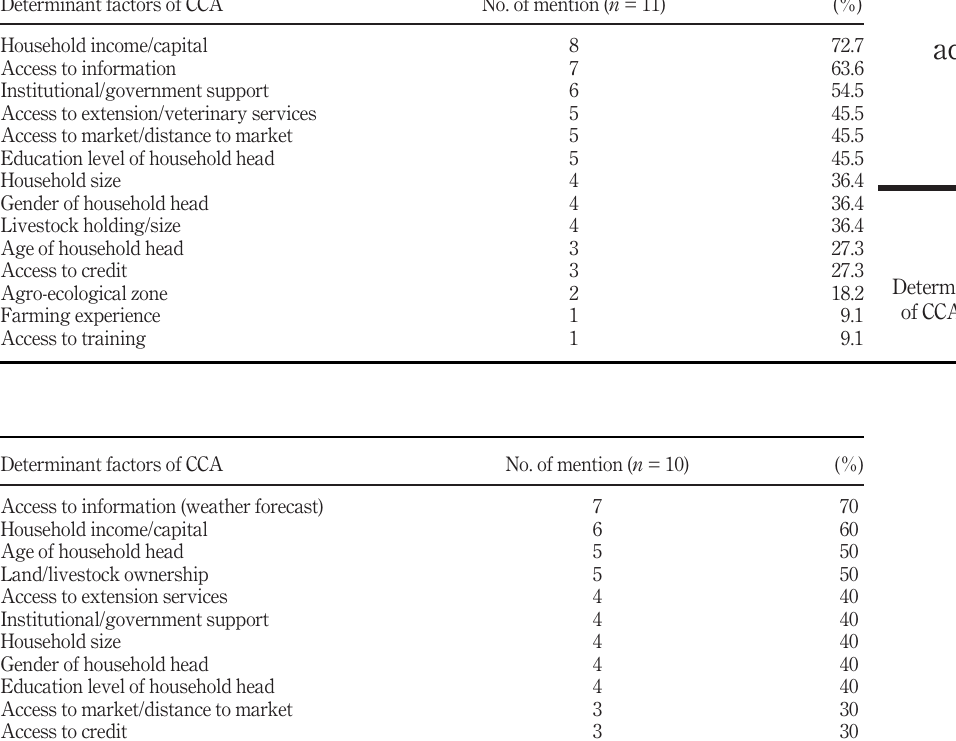
of CCA by agro- pastoral